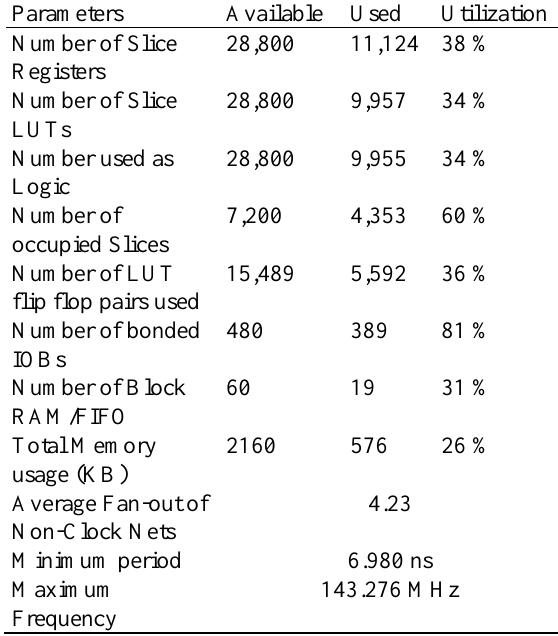
Table 2 Synthesis Summary of Proposed